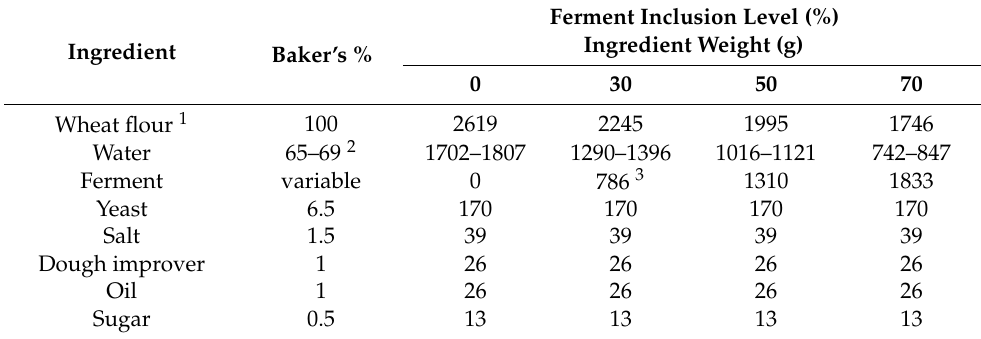
Table 5. Bread formulation with adjusted levels of wheat flour and water to compensate for addition of